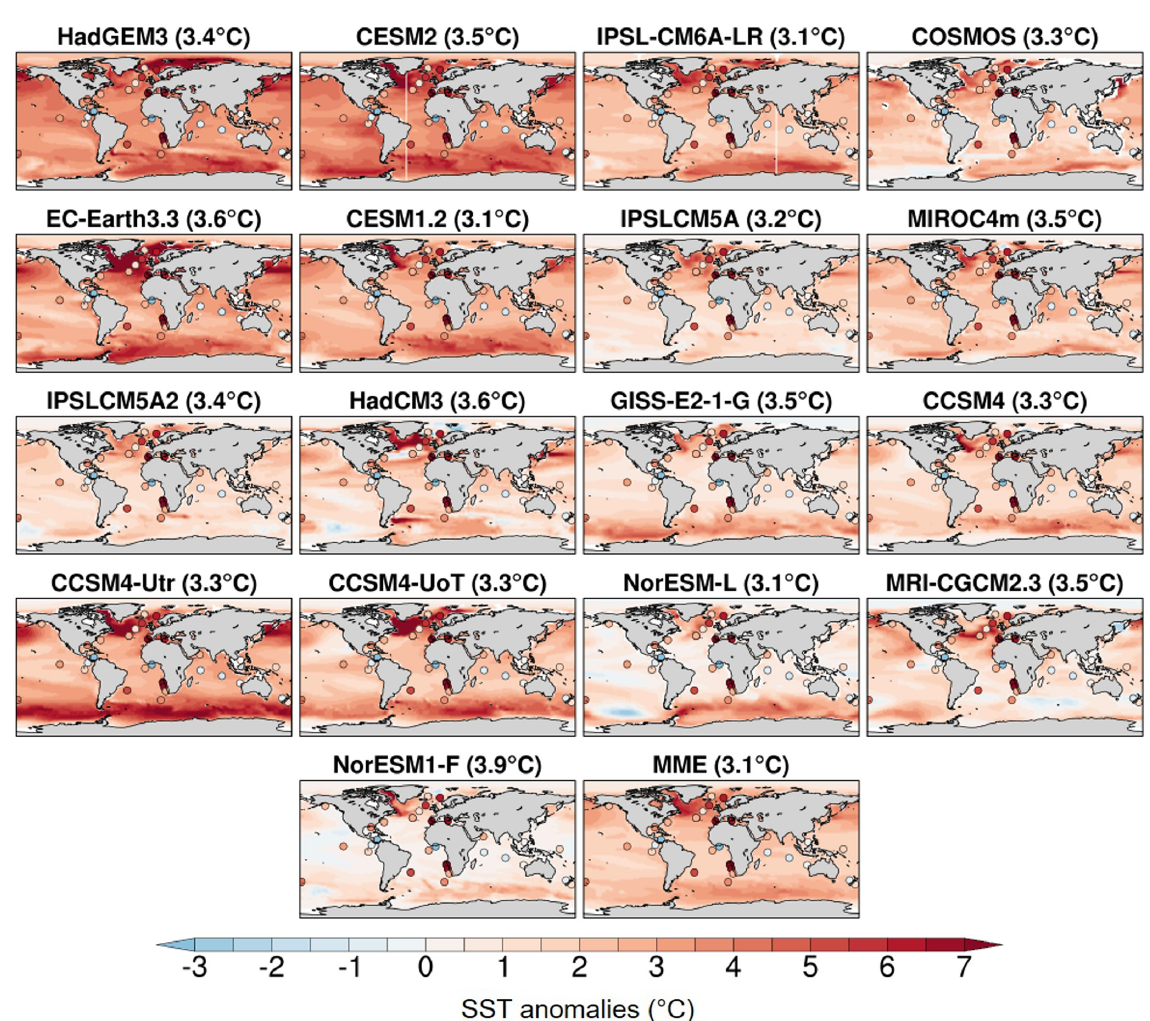
Figure 15. SST climatology differences (Pliocene − PI) from HadGEM3 mPWP simulation and all other models in PlioMIP2, as well as multi-model ensemble mean (MME). Numbers in brackets show RMSE scores when compared proxy data from McClymont et al.